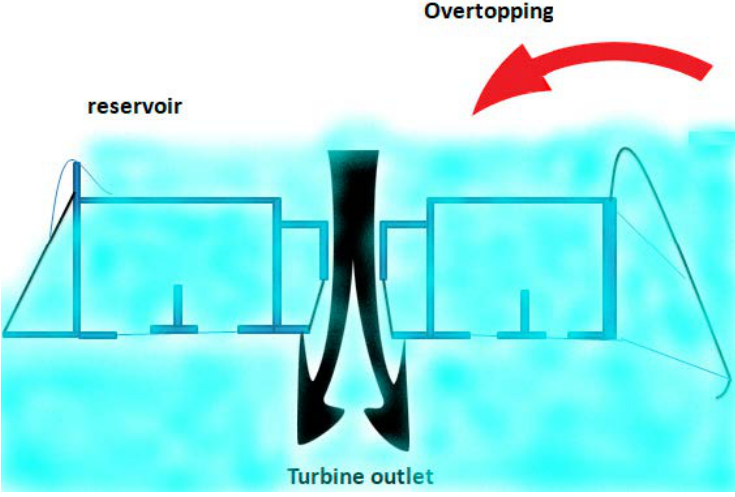
Figure 9. Overtopping wave power